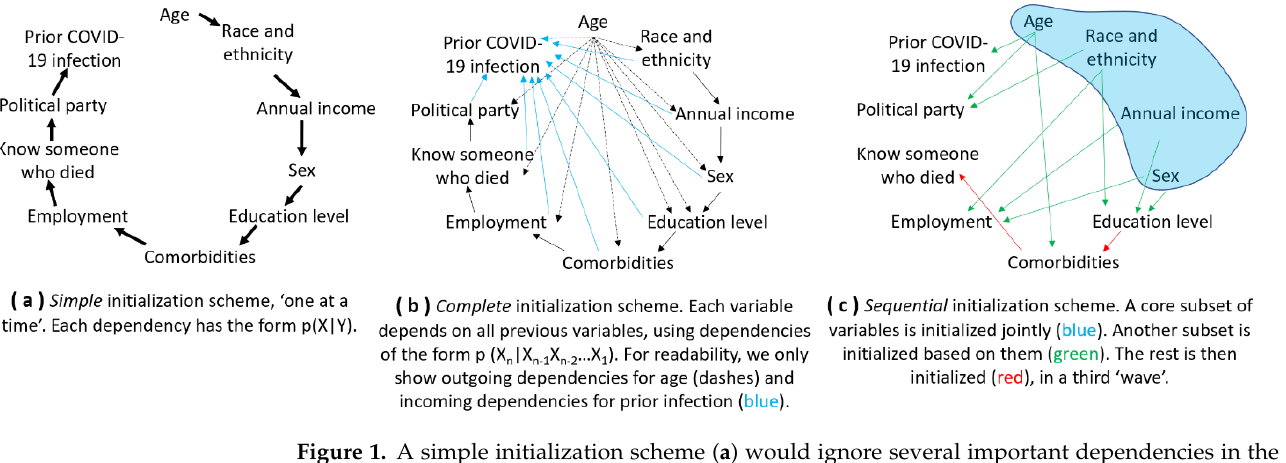
Figure 1. A simple initialization scheme ( a ) would ignore several important dependencies in the data, but capturing a large number of dependencies ( b ) may be infeasible given data limitations. A practical approach is thus to initialize the agents’ attributes in consecutive waves ( c ).